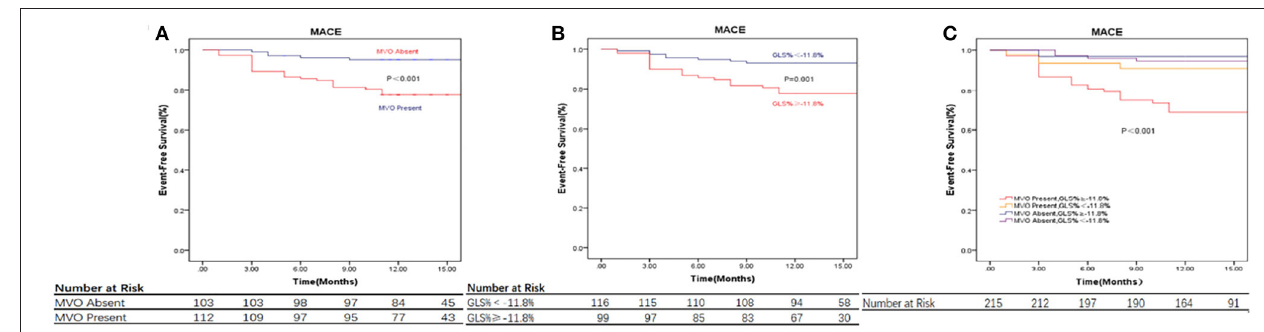
FIGURE 3 | CMR parameters and clinical outcome. (A) Displaying the relationship between MVO, Values are Kaplan-Meier estimates in patients with MVO vs. patients without MVO, indicating the time to major adverse cardiovascular events (MACE). (B) Displaying the relationship between GLS, Values are Kaplan-Meier estimates in patients with GLS ≥ − 11.8% vs. < -11.8%, indicating the time to MACE. (C) Displaying the relationship between MVO and GLS and Event-Free Survival, Values are Kaplan-Meier estimates in patients with GLS ≥ − 11.8% vs. < -11.8%, grouped by the presence or absence of MVO, indicating the time to MACE. Patients with GLS ≥ − 11.8% and MVO had the highest event rates. MACE, major adverse cardiac events; GLS, global longitudinal strain; IS, infarct size; MVO, microvascular obstruction.